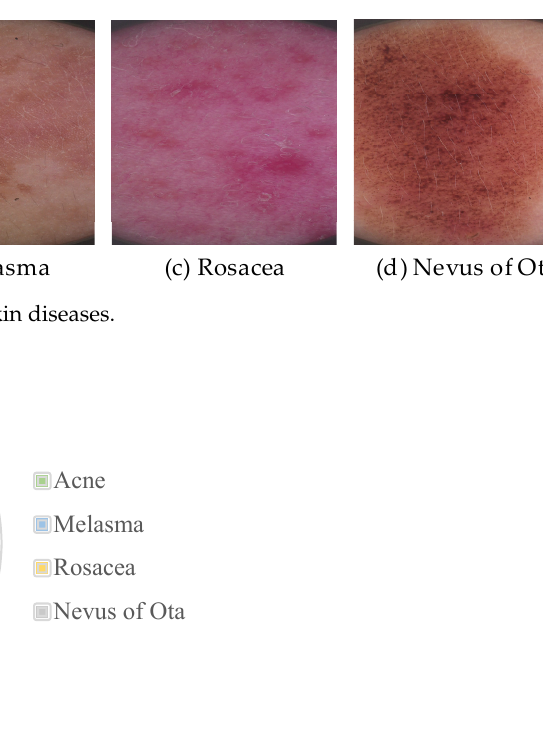
Figure 5. The number of images of each class of skin disease in the test set.